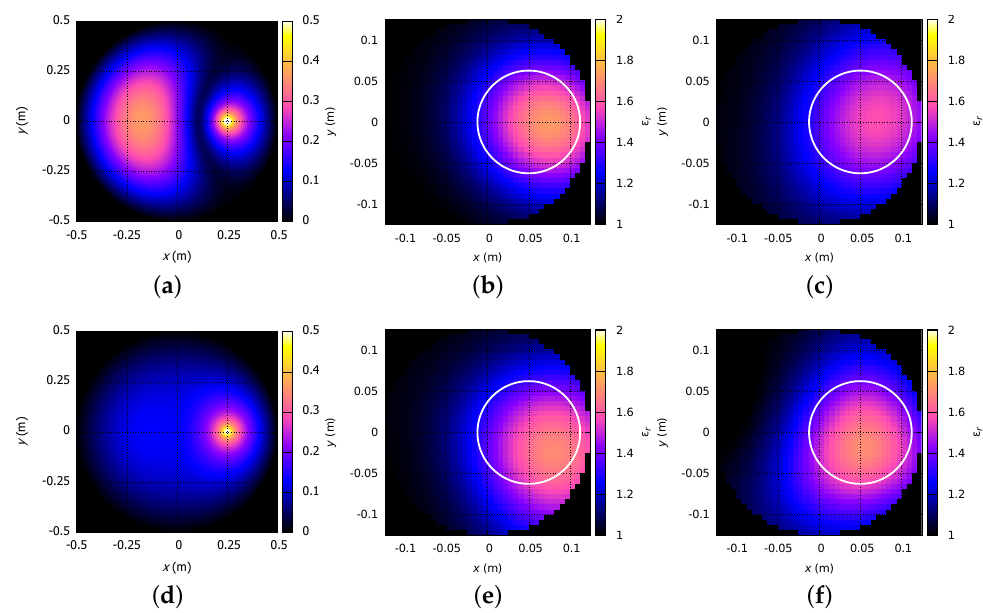
Figure 6. Examples of Green’s functions and reconstructed distributions of the relative dielectric permittivity with small conducting enclosure, a = λ /2. Upper row: results with σ b = 1 mS/m: ( a ) Green’s function magnitude for a source at ( ρ s ,0 ) ; ( b ) Reconstruction with cylindrical enclosure; ( c ) Reconstruction in free space. Lower row: results with σ b = 10 mS/m: ( d ) Green’s function for point source located at ( ρ s ,0 ) ; ( e ) Reconstruction with cylindrical enclosure; ( f ) Reconstruction in free space.